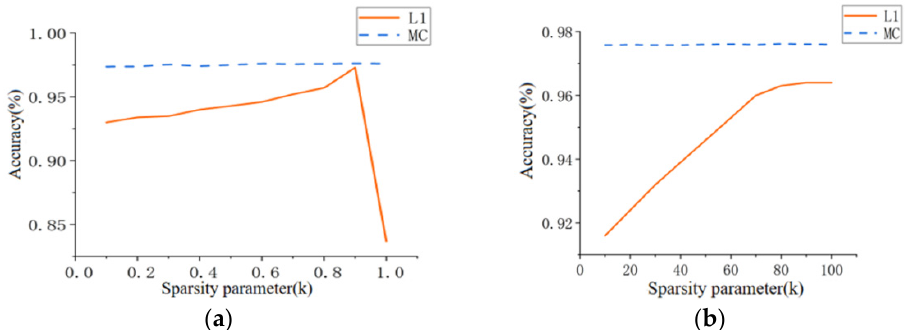
Figure 4. Different sparsity parameters 𝑘 robustness. ( a ) robustness of sparsity parameter k < 1, and ( b ) robustness of sparsity parameter k > 1.